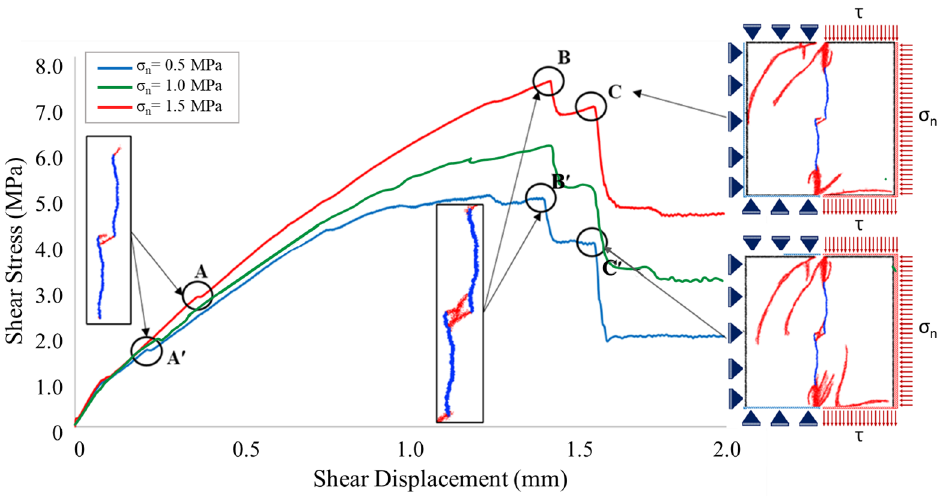
Figure 13. Shear strength–shear displacement curve for pre-cracked specimens under the σ n of 0.5 and 1.5 MPa.